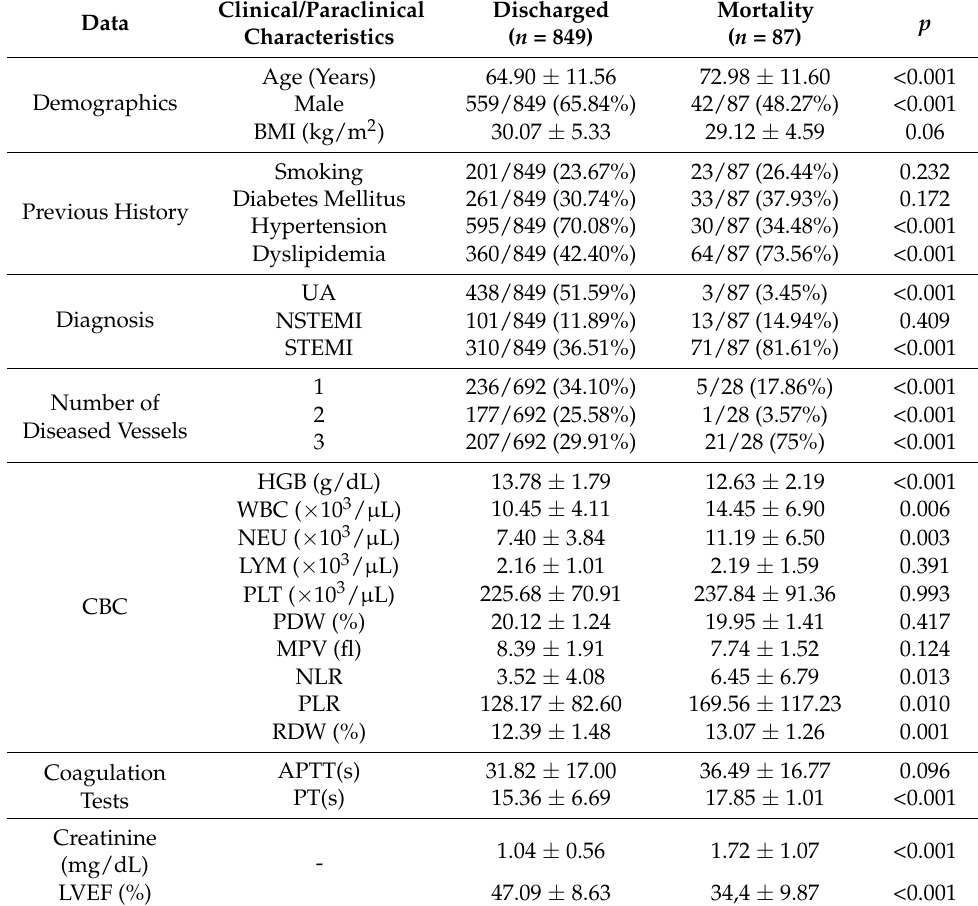
Table 1. Clinical/paraclinical data of the mortality group vs. discharged group in ACS